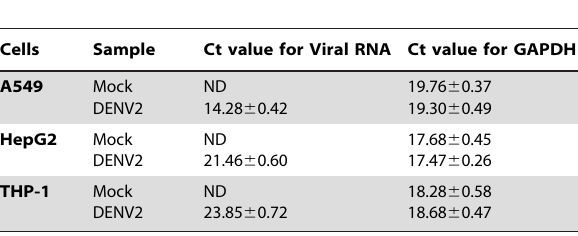
Table 1. Viral RNA levels in DENV2-infected A549, HepG2 and THP-1